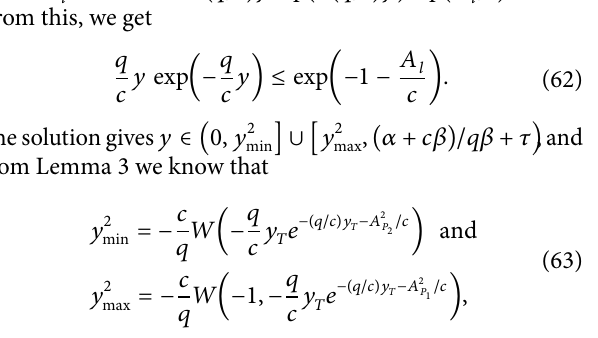
. (b) 퐴 𝑙 = −0.2054 , , 푞 = 1.3 휆 = 0.52